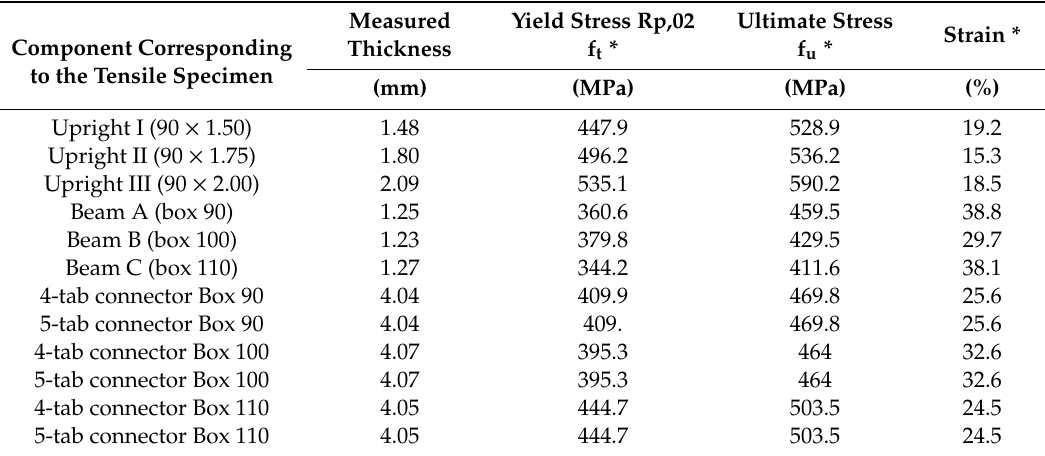
Table 5. Material properties for tested